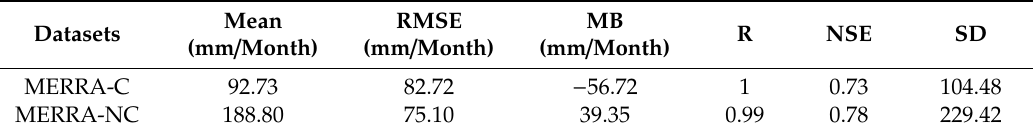
Figure 4. Monthly precipitation cycle (mm/month) derived from observations, MERRA-C, and MERRA-NC for study region from January 2000 to December 2018. Table 1. The RMSE, MB, R, and Nash–Sutcliffe efficiency (NSE) between MERRA-2 and observed datasets based on the monthly mean value from 2000 to 2018 over the study area. SD represents the standard deviation of respective datasets.